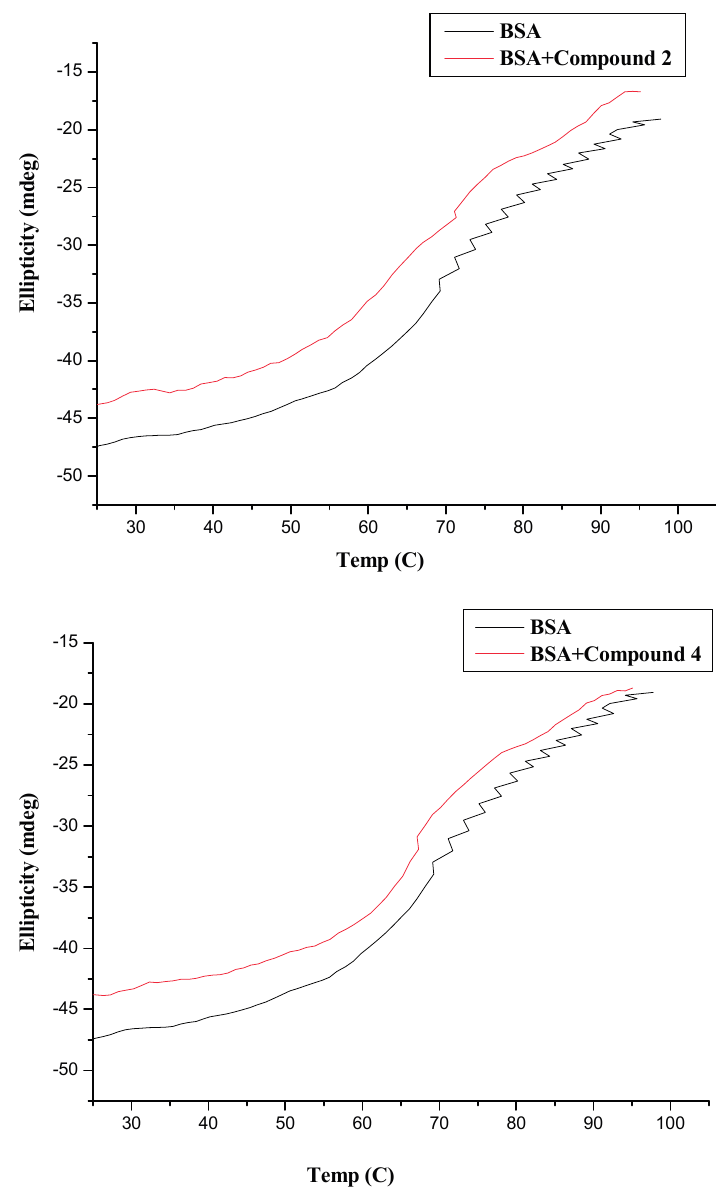
Figure 12. Thermal denaturation of 40 × 10 − 6 mol·L –1 BSA in the absence and presence of 120 × 10 − 6 mol·L –1 compounds at pH =